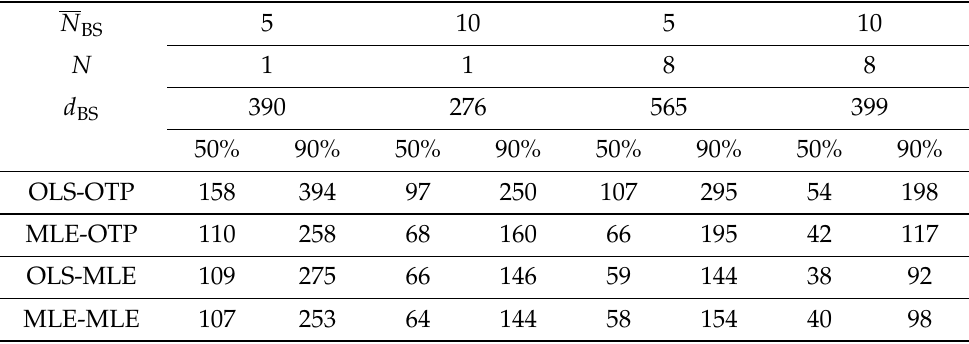
Table 8. Positioning error, in meters, 50th and 90th percentiles of Example 3 (28 GHz). Base stations have omnidirectional ( N = 1) or directional antennas ( N = 8) and the average number of contacted BSs is N BS = 5 or 10. N